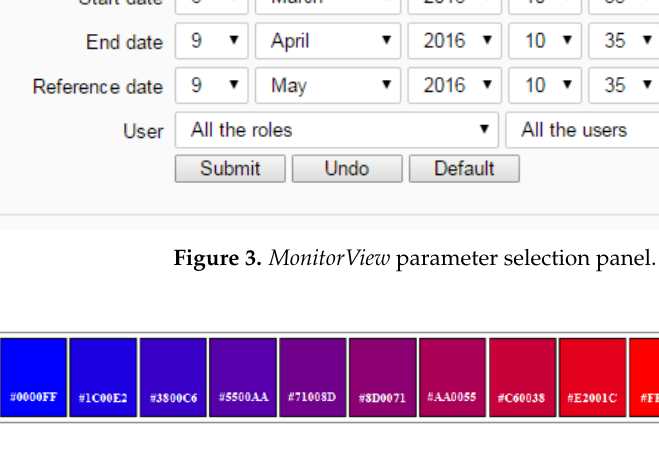
Figure 4. Colour